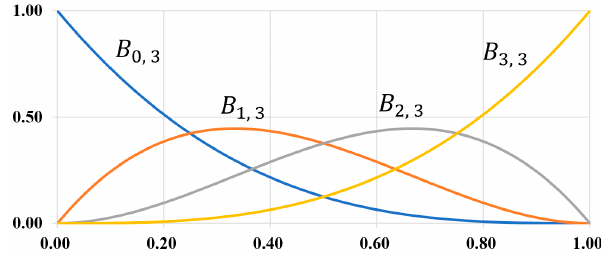
Figure 2. Cubic Bernstein polynomials among a unit interval.